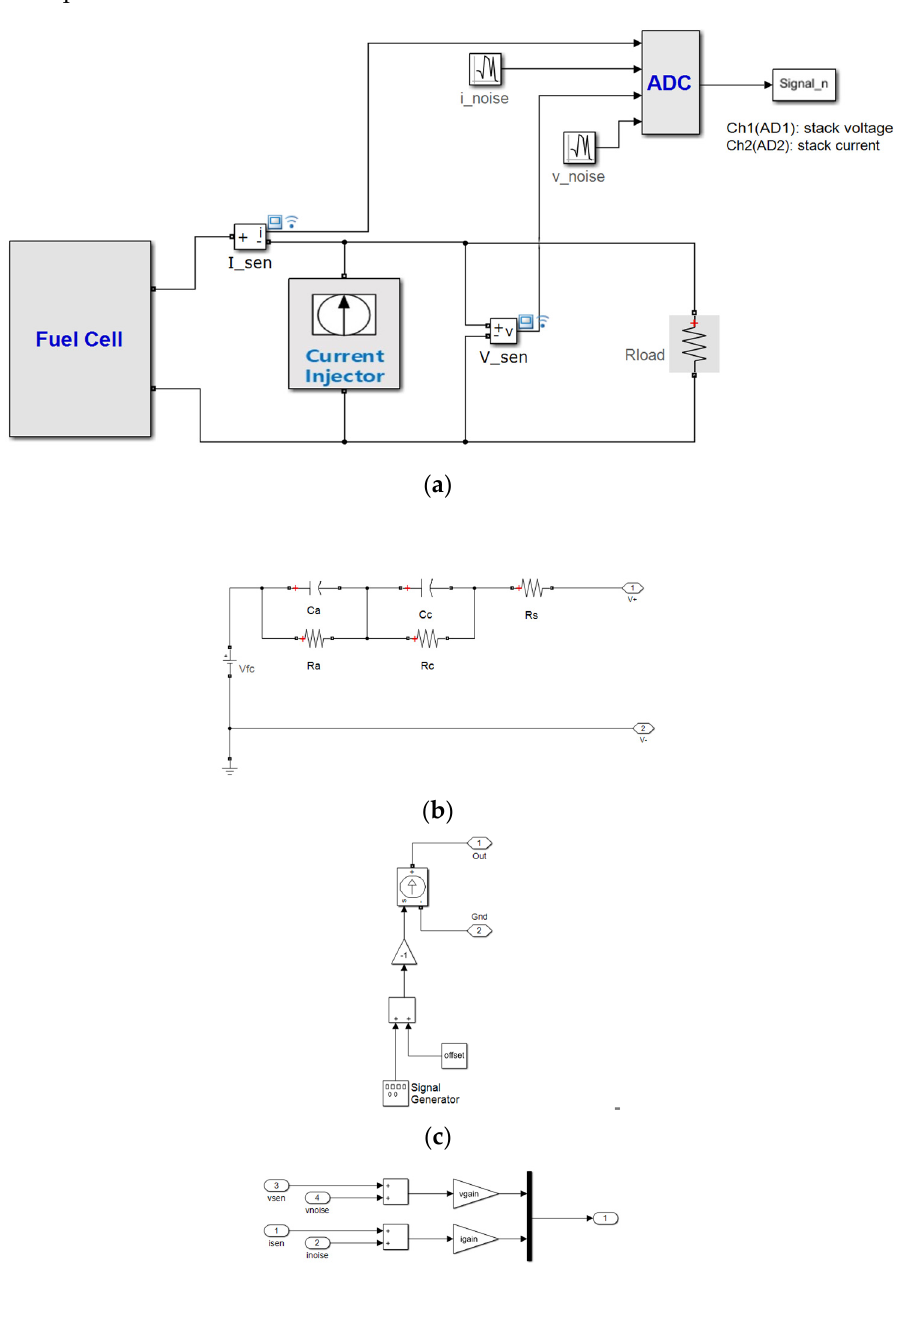
Figure 4. Simulink model for simulations of the proposed EIS. ( a ) Simulink model for fuel cell power system. ( b ) Fuel cell model. ( c ) Current injector model. ( d ) ADC model.